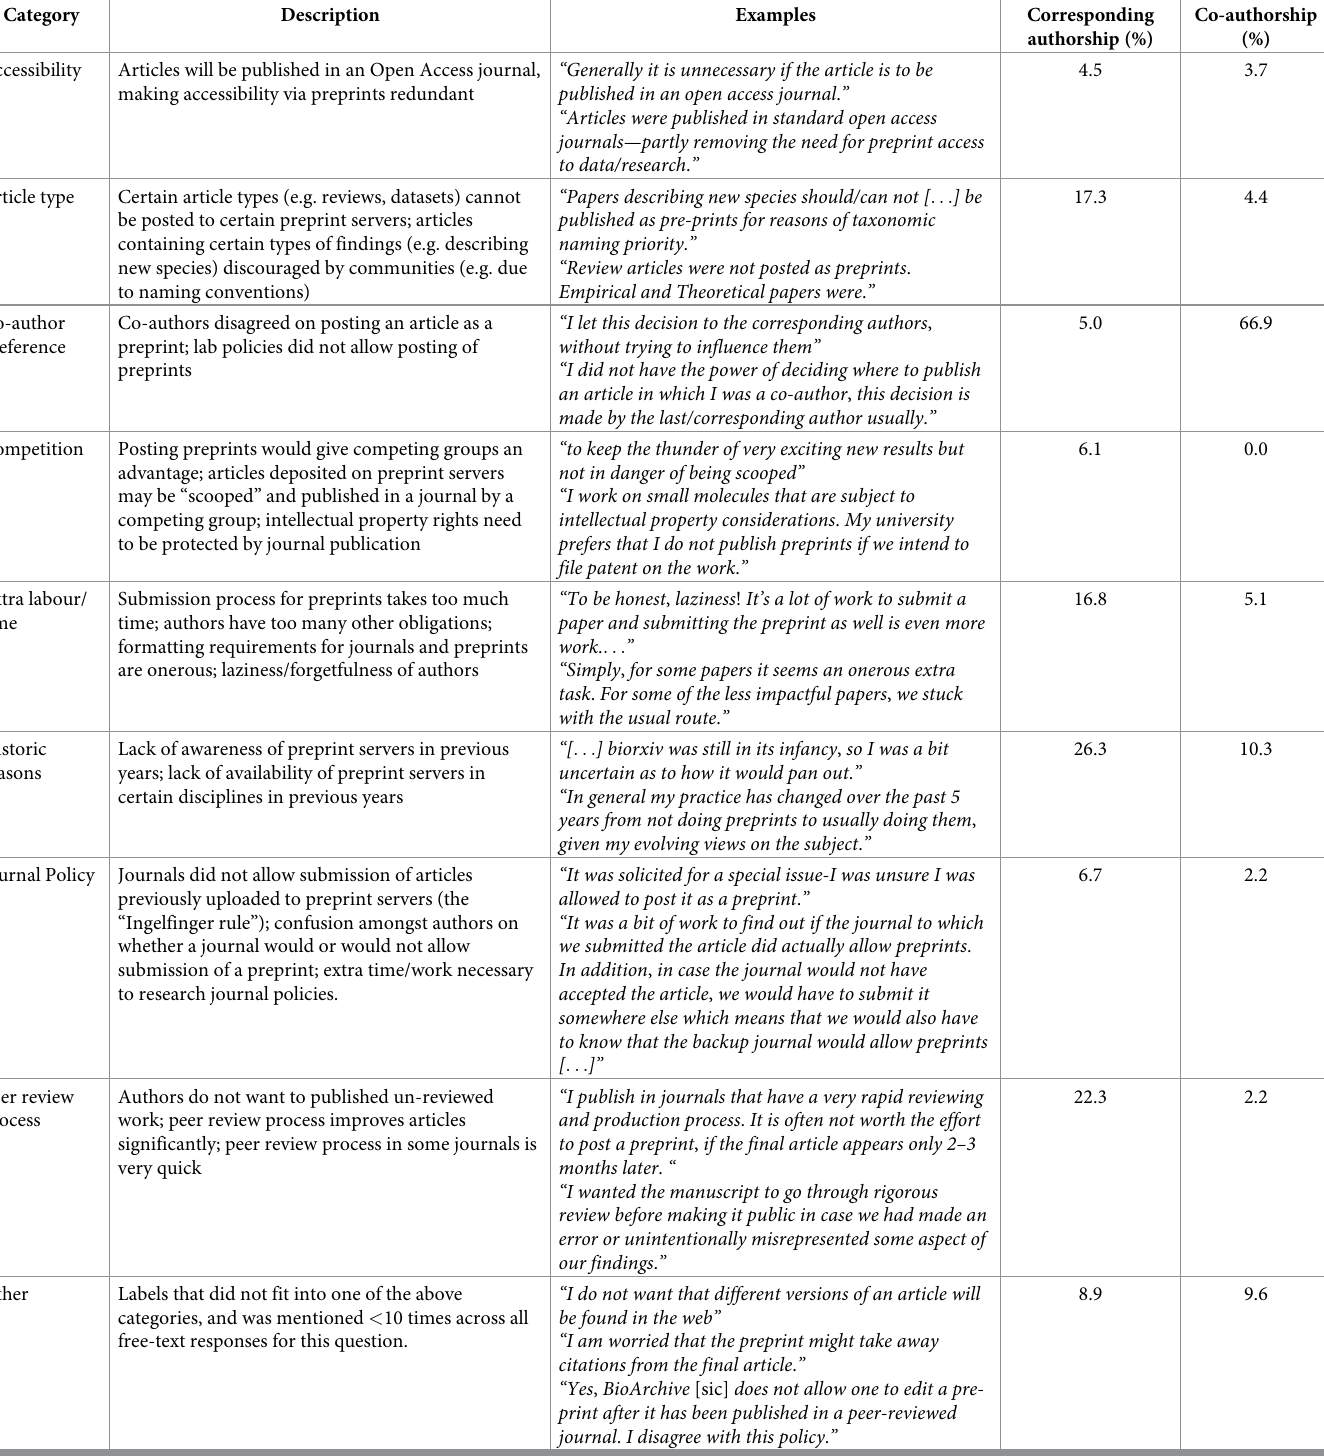
Table 6. Classification of free-text responses, in response to the question “Were there any additional reasons that caused you to not deposit these articles as pre- prints?”. Categories are ordered alphabetically (except for “Other”). Percentages for corresponding and co-authorships refer to the proportion of all responses containing the relevant category; responses could contain multiple categories (N = 180 comments on corresponding authorships, 137 comments on